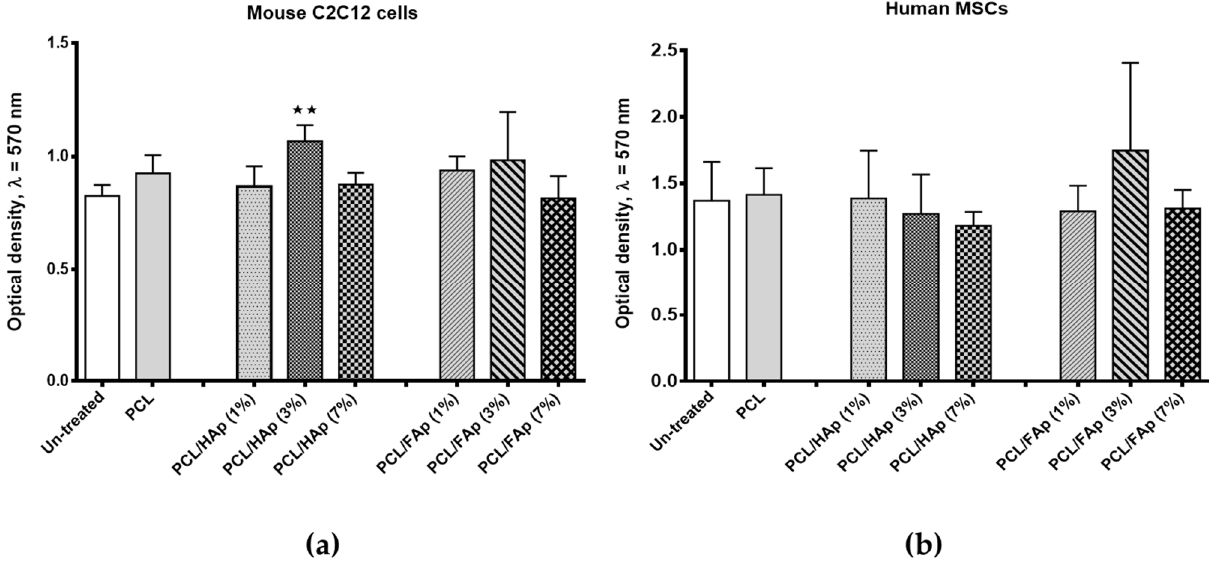
Figure 3. The effect of PCL/HAp and PCL/FAp scaffold extracts on the in vitro growth of ( a ) mouse C2C12 cells and ( b ) human MSCs measured using MTT assay. Data are presented as mean ± SD ( n = 3). p -values were calculated based on the t -test. Asterisks show the significance levels of difference for particular variants versus un-treated cells (** for p < 0.01).